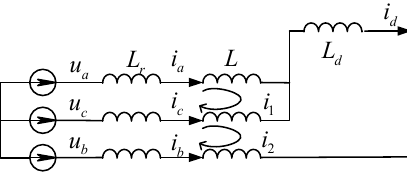
Figure 4. L/C switch equivalent circuit when VT1 is in conduction commutation state.